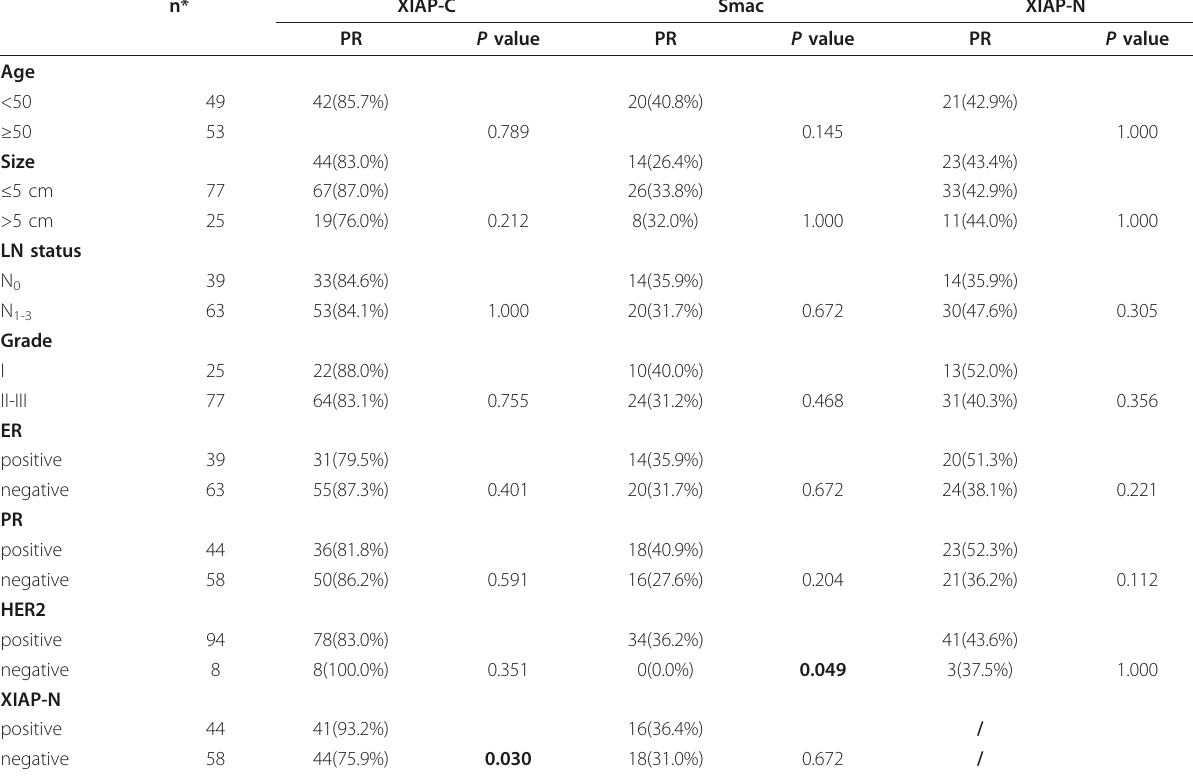
Table 2 Relationship analysis between positive rate of XIAP/Smac and clinicopathologic